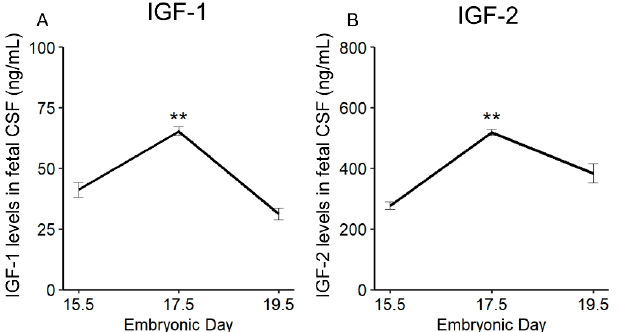
Figure 3. Physiological change in IGF-1 and IGF-2 levels in fetal cerebrospinal fluid (CSF). The levels of IGF-1 and IGF-2 in the CSF peaked at E17.5: ( A ) IGF-1: E17.5 vs. E15.5, p < 0.01; E19.5 vs.